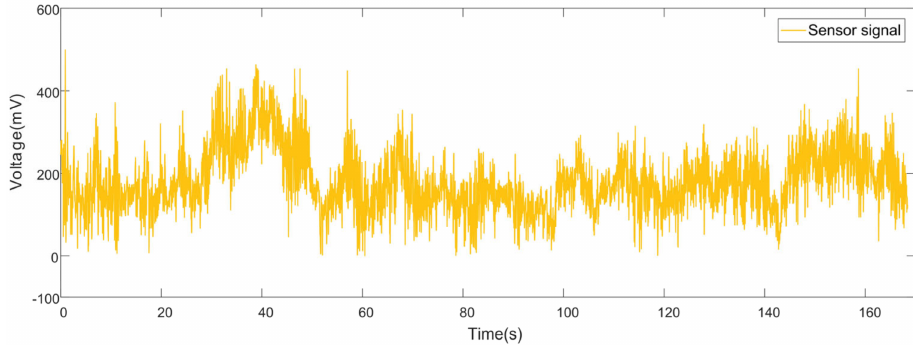
Figure 15. Sensor original signal. Figure 14. Sunflower harvesting field experiment: ( a ) 4ZXRKS-4 type self-propelled sunflower com- bine harvester; and ( b ) impact-type sunflower yield sensor.